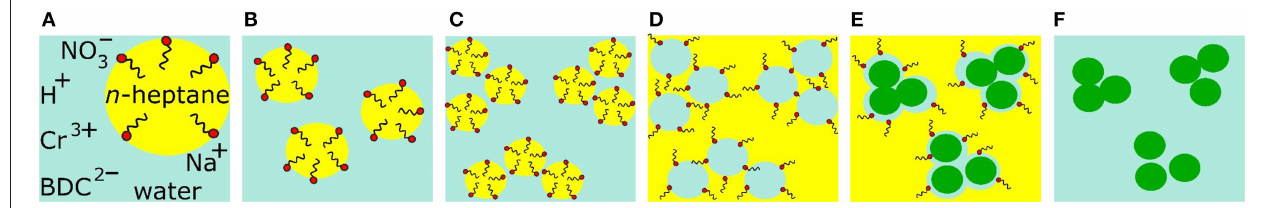
FIGURE 1 | The anticipated direct emulsion mechanism for the formation of nanoMIL-101Cr (depicted as green spheres). BDC 2 − , benzene-1,4-dicarboxylate; Cr 3 + , chromium salt; NO − 3 , nitrate ion; and micelles with hydrophobic groups of sodium oleate oriented toward the center of heptane oil droplets (hydrophilic groups = red spheres). MOF precursors are in the aqueous phase (A) . At higher temperature, the heptane droplets expand rapidly (B) , at the PIT (phase inversion temperature) the size of the heptane droplet reaches a minimum (C) , phase inversion occurs (D) , reverse micelles work as nanoreactors for nanoMIL-101Cr and in addition coalescence occurs (E) , isolated and agglomerated nanoMIL-101Cr particles in water after washing procedure (F)